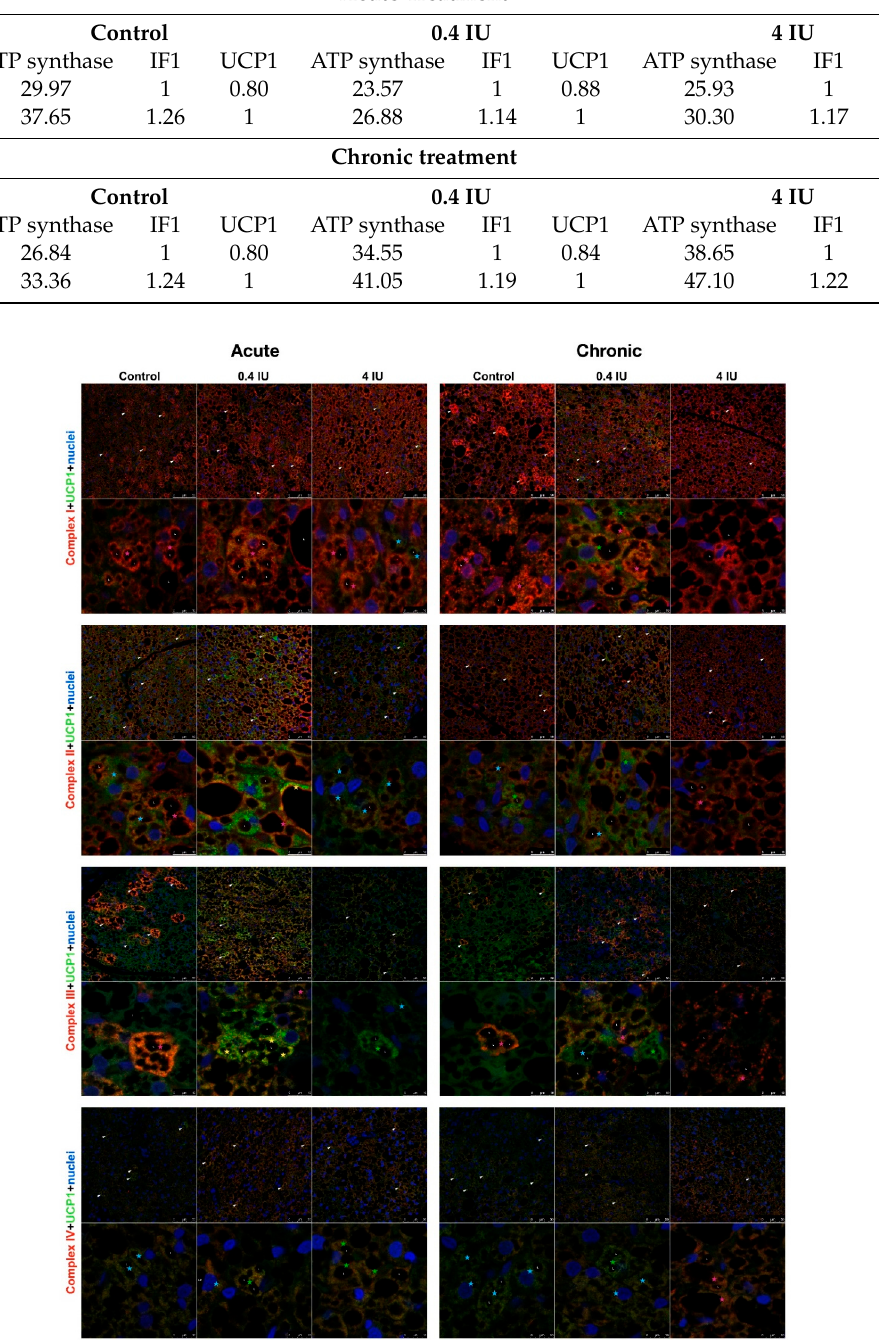
Figure 9. Immunofluorescence of UCP1 and ETC complexes in BAT following acute and chronic insulin treatment. Double labeling with antibodies against UCP1 (green) and ETC complexes (red). Harlequin effect is shown with arrowheads. BAT showed various brown adipocytes with different degree of immunoexpression: UCP1-only brown adipocytes (light-blue star); UCP1 predominantly positive brown adipocytes (green star); brown adipocytes with clear colocalization of UCP1 and specific ETC complex (yellow star); specific ETC complex predominantly positive brown adipocytes (pink star); and specific ETC complex-only brown adipocytes (red star). L—lipid bodies. Nuclei were stained with Sytox Orange. Scale bar = 50 µm (first row) and 10 µm (second row). In all experimental groups, brown adipocytes showed a clear heterogeneous immunolocalization of different ETC complexes and UCP1, known as the Harlequin effect (Figure 9).